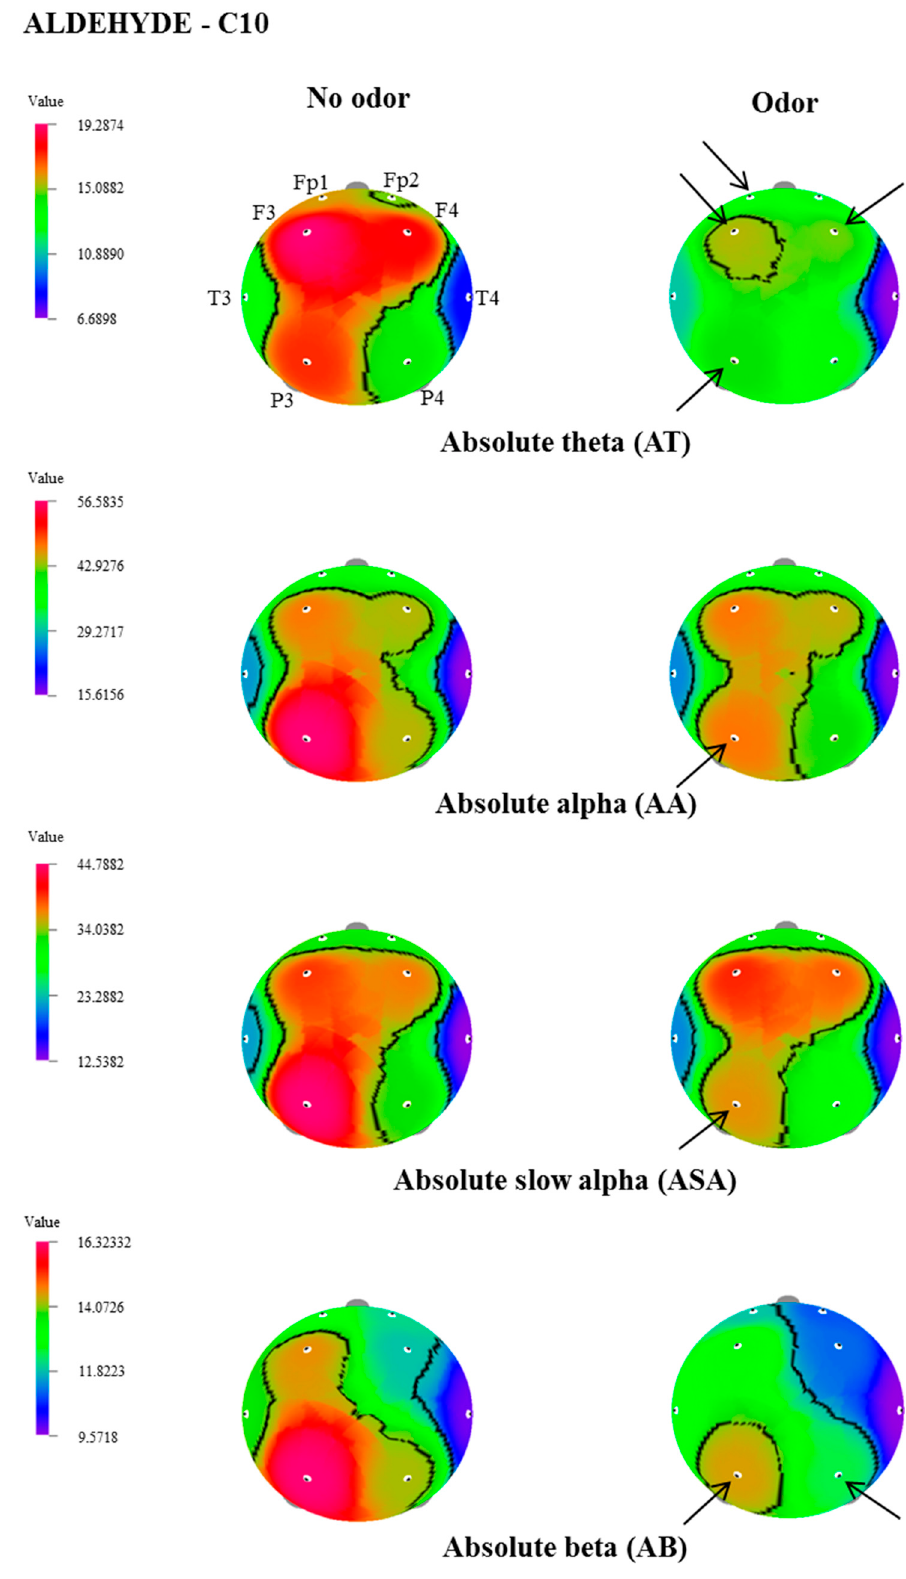
Figure 3. The t-Mapping of EEG power spectrum changes during the right nostril inhalation of C10 aldehyde. Fp1, left prefrontal; Fp2, right prefrontal; F3, left frontal; F4, right frontal; T3, left temporal; T4, right temporal; P3, left parietal; P4, right parietal. Arrows show significant changes in the regions during the inhalation of C10.